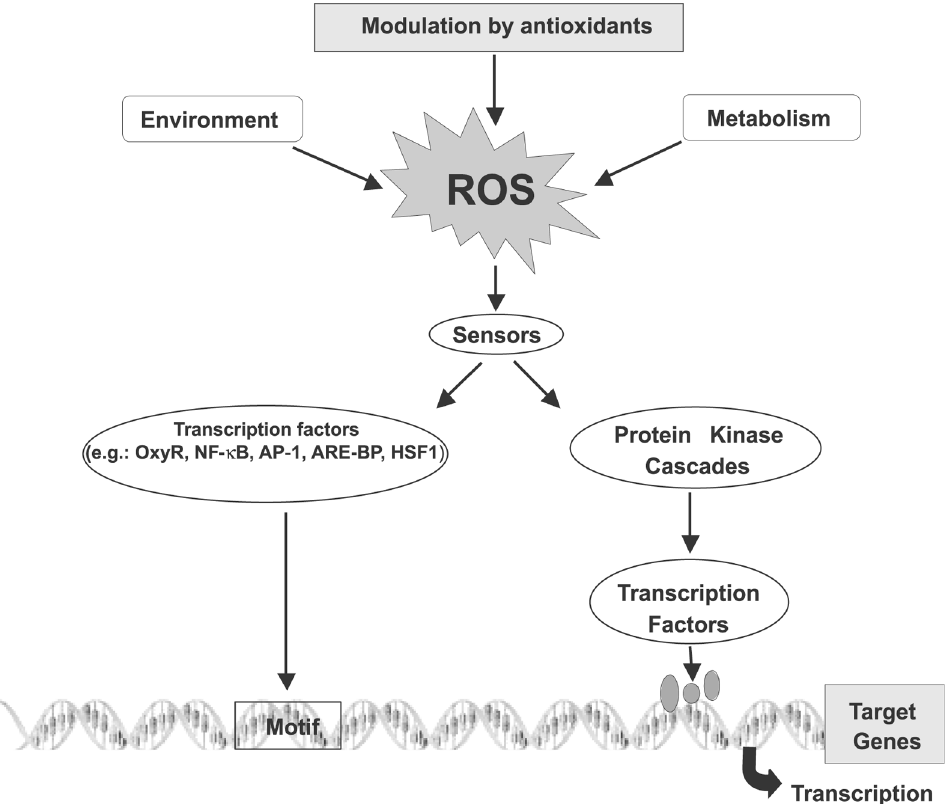
Figure 11. The major signaling pathways activated in response to oxidative stress. Reactive oxygen species (ROS) originat- ing from environmental signals or from metabolic activity are modulated by antioxidants to nontoxic levels, at which point they serve as signaling mol- ecules. ROS can activate gene transcription in two ways: a)